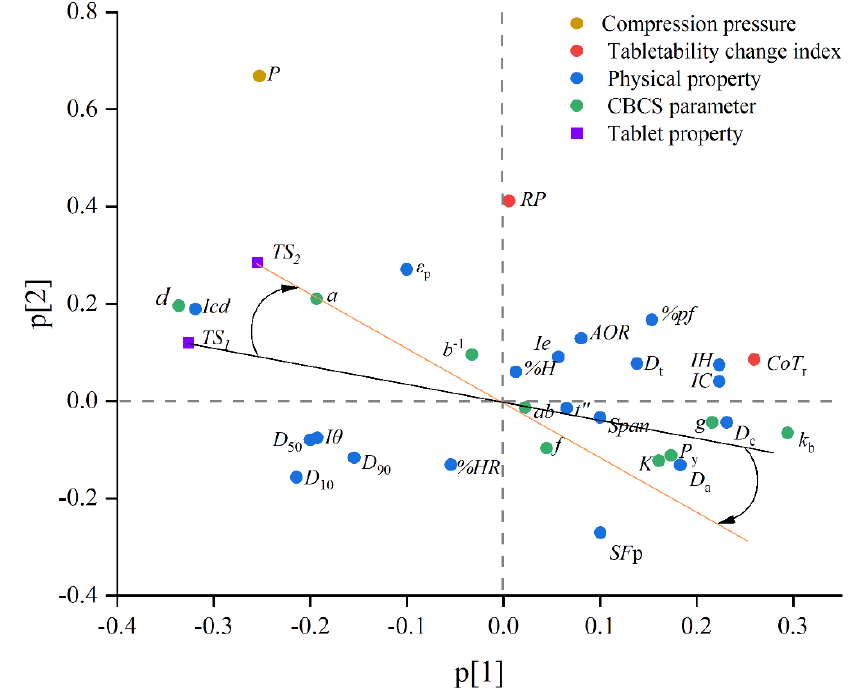
Figure 8. The loading plot for the PLS2 model based on the first two latent variables. (The yellow circle represents the compression pressure. The red circles represent the tabletability change indexes. The blue circles represent the physical properties. The green circles represent the CBCS parameters. The purple squares represent the tablet tensile strength. The black line represents the direction of variables associated with TS1. The yellow line represents the direction of variables associated with TS2. The arrows represent the shift in the physical properties of raw materials required by DC and HSWGT).